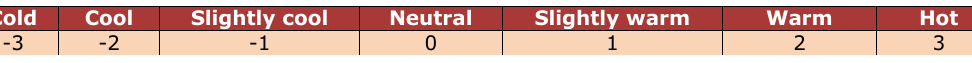
Table 4. ASHRAE 7-point psycho-physical scale